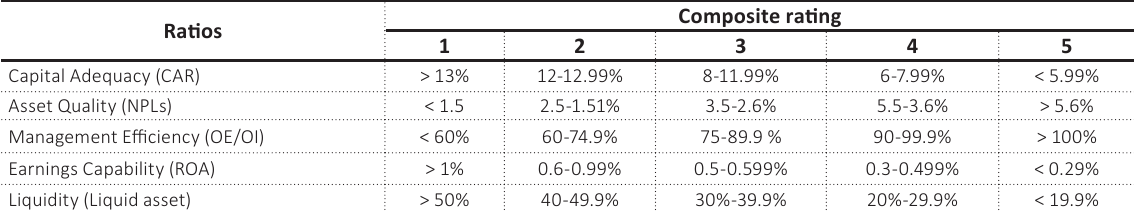
Table 4. Classification rating of CAMEL parameters